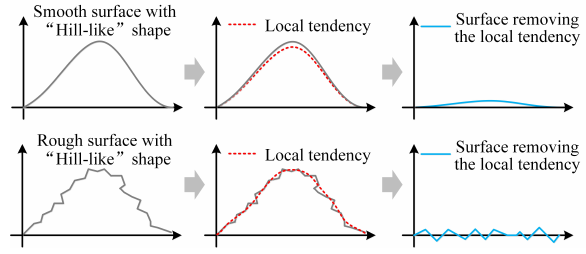
Figure 4. Local tendency of the geometric shapes.